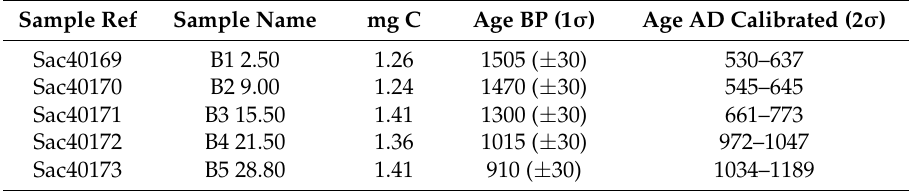
Table 1. 14 C datation of Valpareso sample. BP: Before Present; AD: Anno